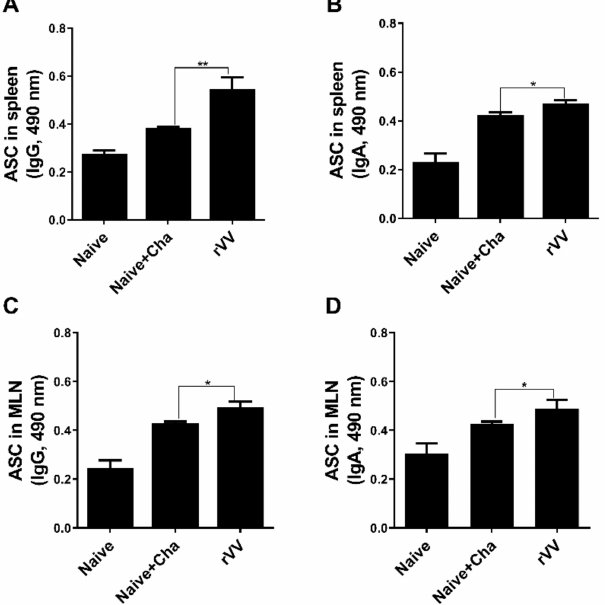
Figure 3. Antibody-secreting cell responses in secondary lymphoid organs. At 16 dpi, mice ( n = 6 per group) were sacrificed and the levels of IgG and IgA antibody-secreting cells were evaluated in spleen and MLN cells. Single-cell populations of splenocytes and MLN cells were incubated with T. gondii ME49 lysate antigen. Splenic IgG and IgA ( A , B , respectively) and MLN IgG and IgA ( C , D , respectively) were evaluated by ELISA. Data are presented as mean ± SD from 3 independent experiments performed in triplicates and asterisks indicate statistical differences between groups. (* p < 0.05, ** p <